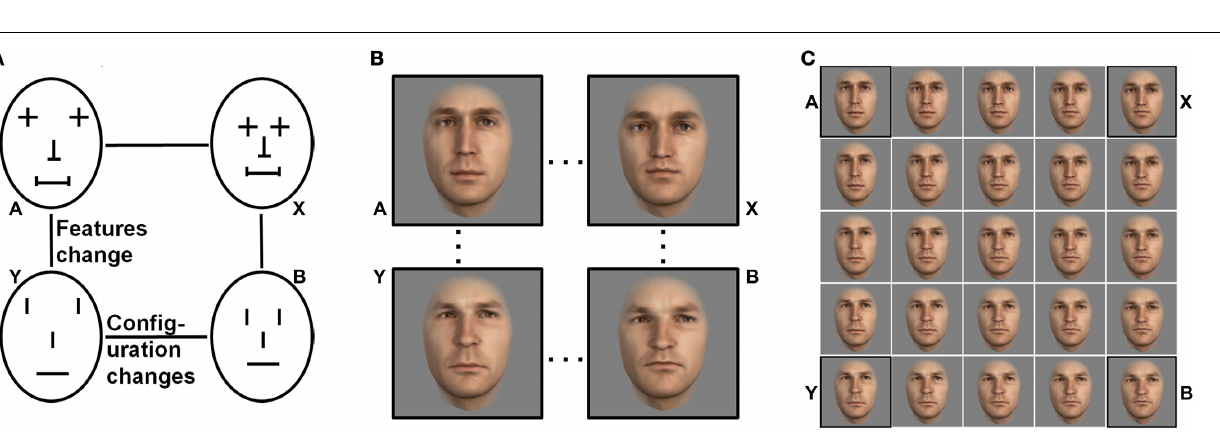
Frontiers in Human